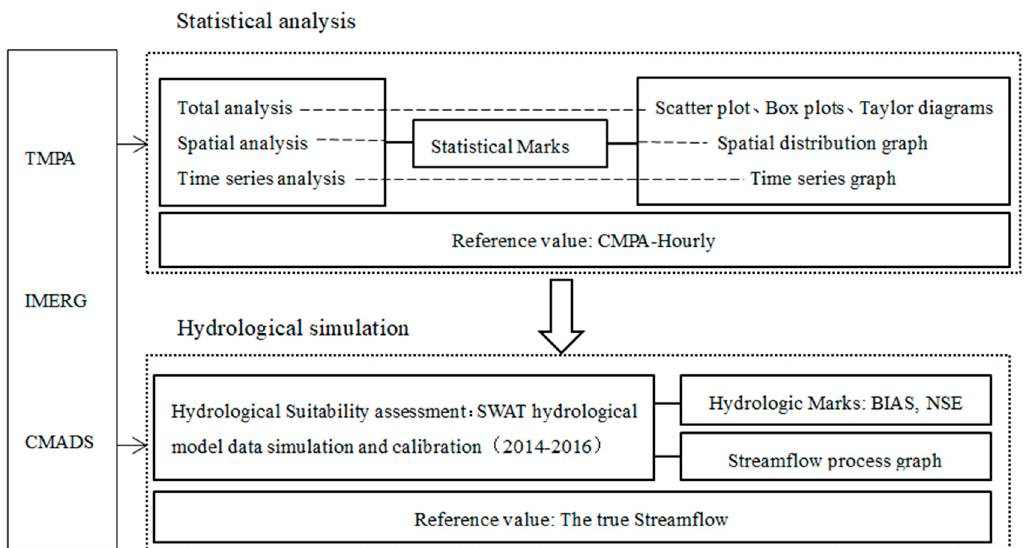
Figure 1. Flowchart of this Figure 1. flowchart of this study.